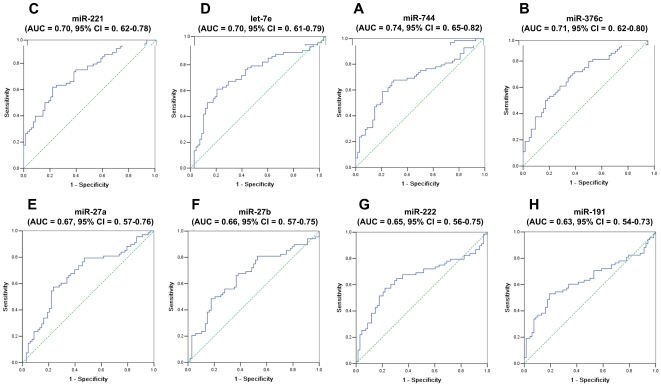
Receiver operating characteristics (ROC) curve analysis using eight serum miRNAs for discriminating 68 GCs from 68 controls.Serum (A) miR-744, (B) miR-376c, (C) miR-221 and (D) let-7e yielded the largest areas under the ROC curves (AUCs).